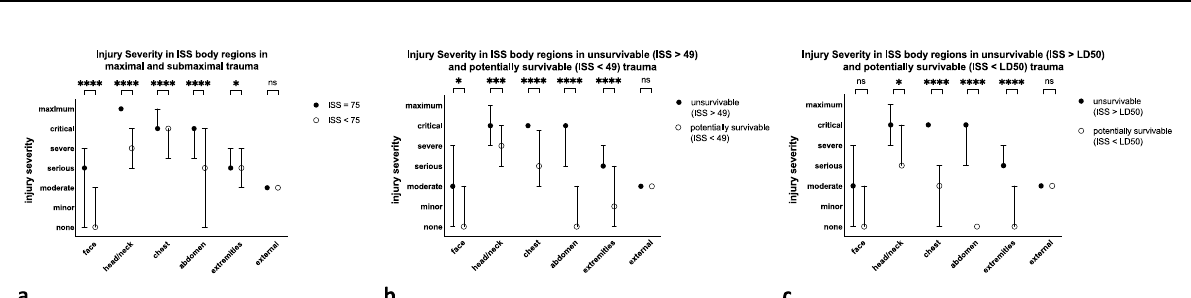
with significance only when comparing maximal to submaximal trauma ( a ). Similarly, MOF was more frequent in